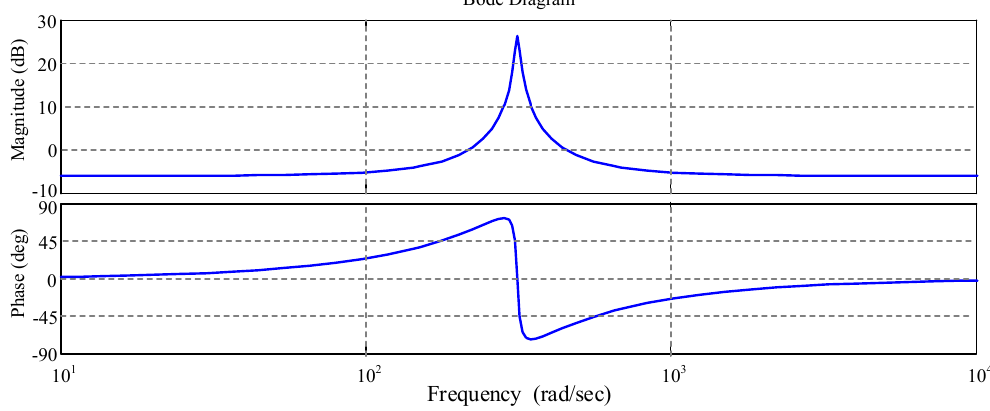
Figure 11. Bode diagram of the quasi-proportional-resonant (QPR) controller.